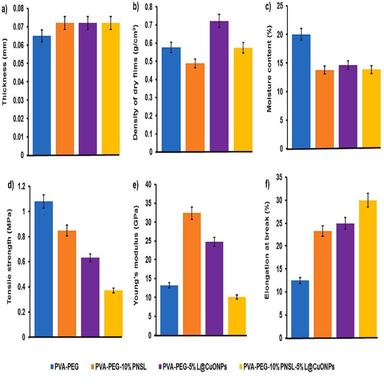
Physicochemical properties of bare PVA-PEG film, PVA-PEG-10%PNSL, PVA-PEG-5%L@CuONPs, and PVA-PEG-10%PNSL-5%L@CuONPs nanocomposite films; a) Thickness; b) Density of dry films; c) Moisture content; d) Tensile strength; e) Young's modulus; f) Elongation at break.